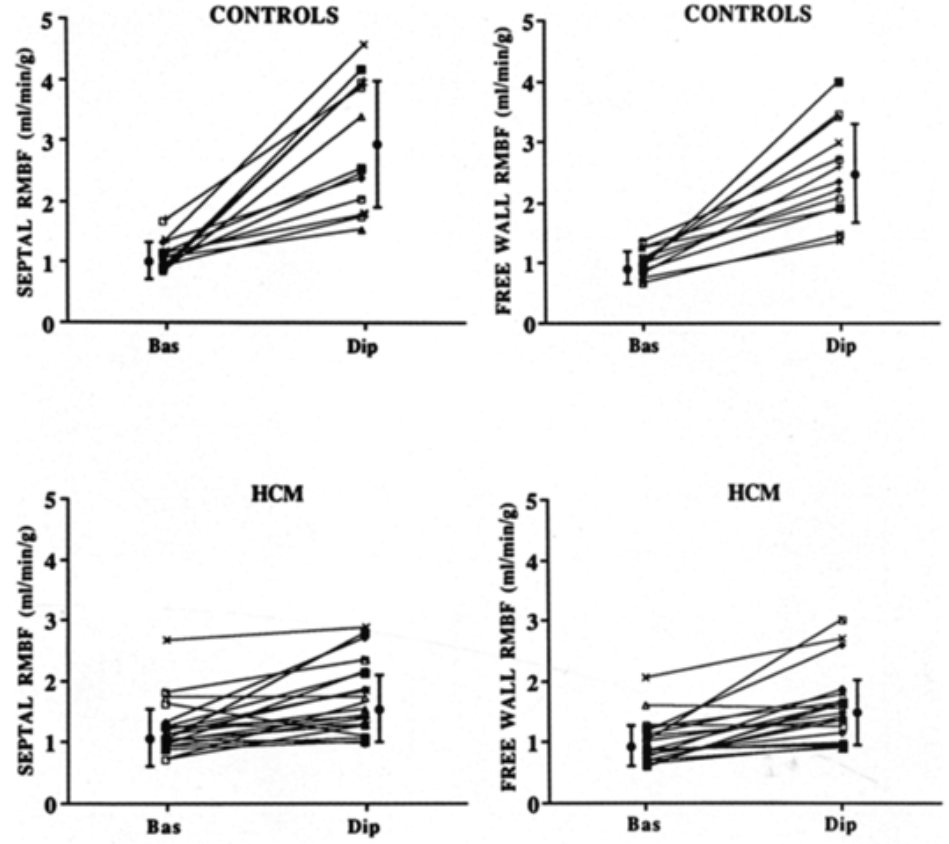
Figure 2. Both microvascular ischemia and replacement fibrosis can be evaluated by CMR, the former by first-pass perfusion and the latter by late gadolinium enhancement (LGE). Importantly, there is a correlation between LGE and the grade of hyperemic MBF assessed by PET, thus suggesting that LGE corresponds—at least in part—to replacement fibrosis secondary to microvascular dysfunction and myocardial ischemia. The figure is from Camici PG et al., with permission [25].